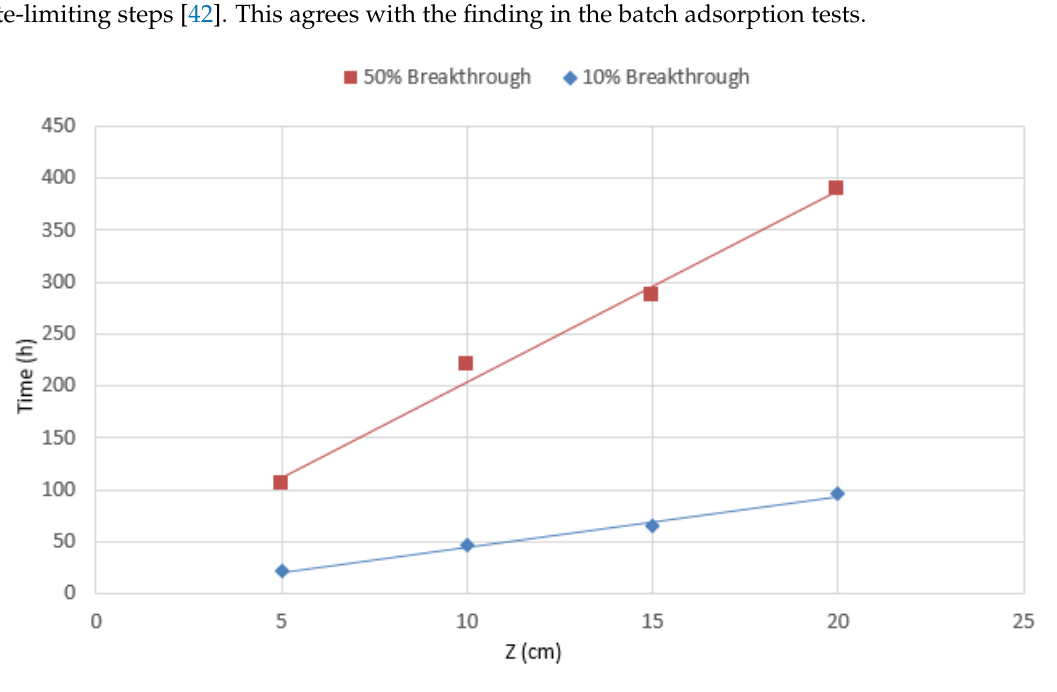
Figure 5. Adam-Bohart plot of EE2 removal by PMPS at 10% and 50% breakthrough points.